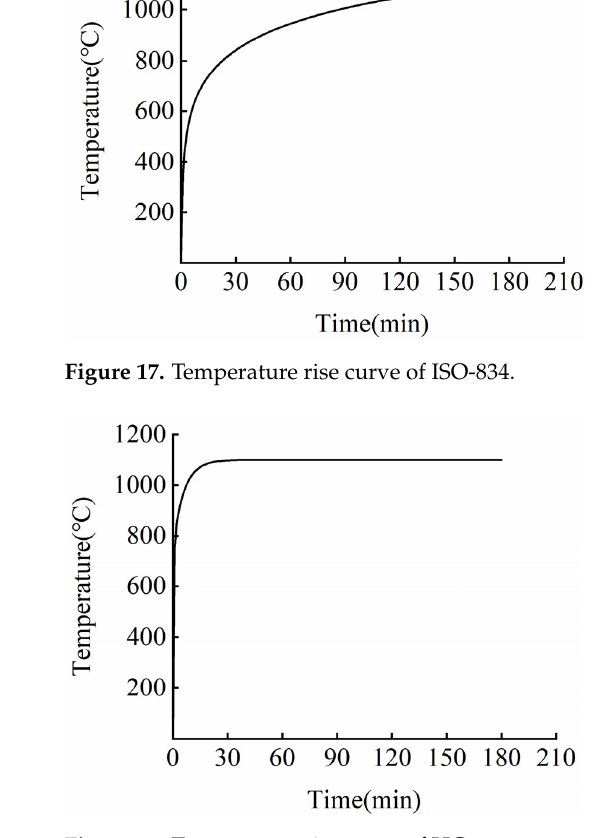
Figure 18. Temperature rise curve of HC.